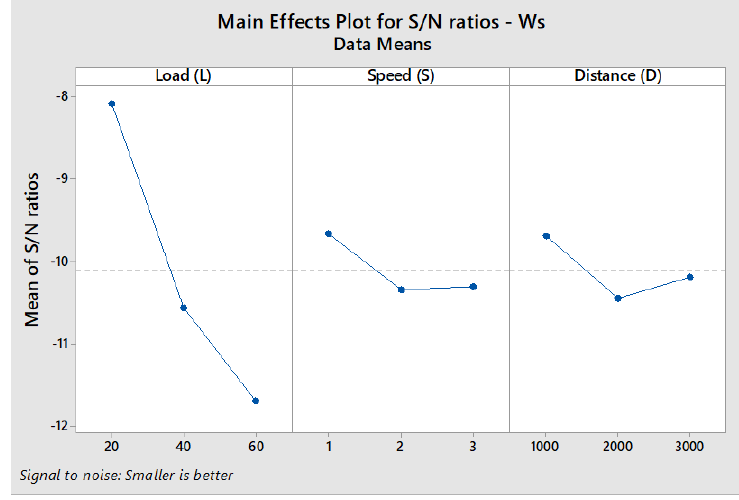
Figure 4. Main Effects Plot for S/N Ratios of W s.